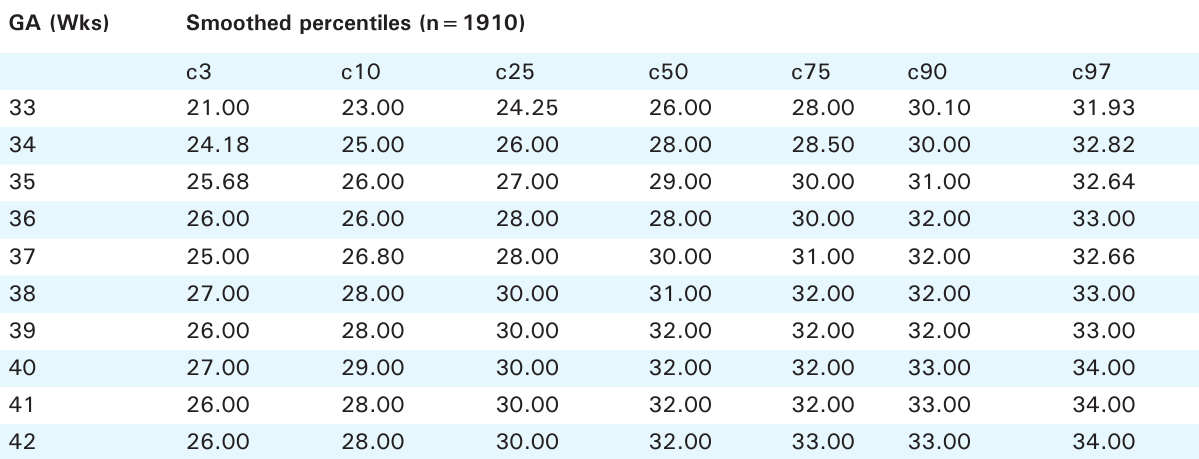
Table 5. Smoothed percentile values of chest circumference for each gestation from 33 to 42 weeks.